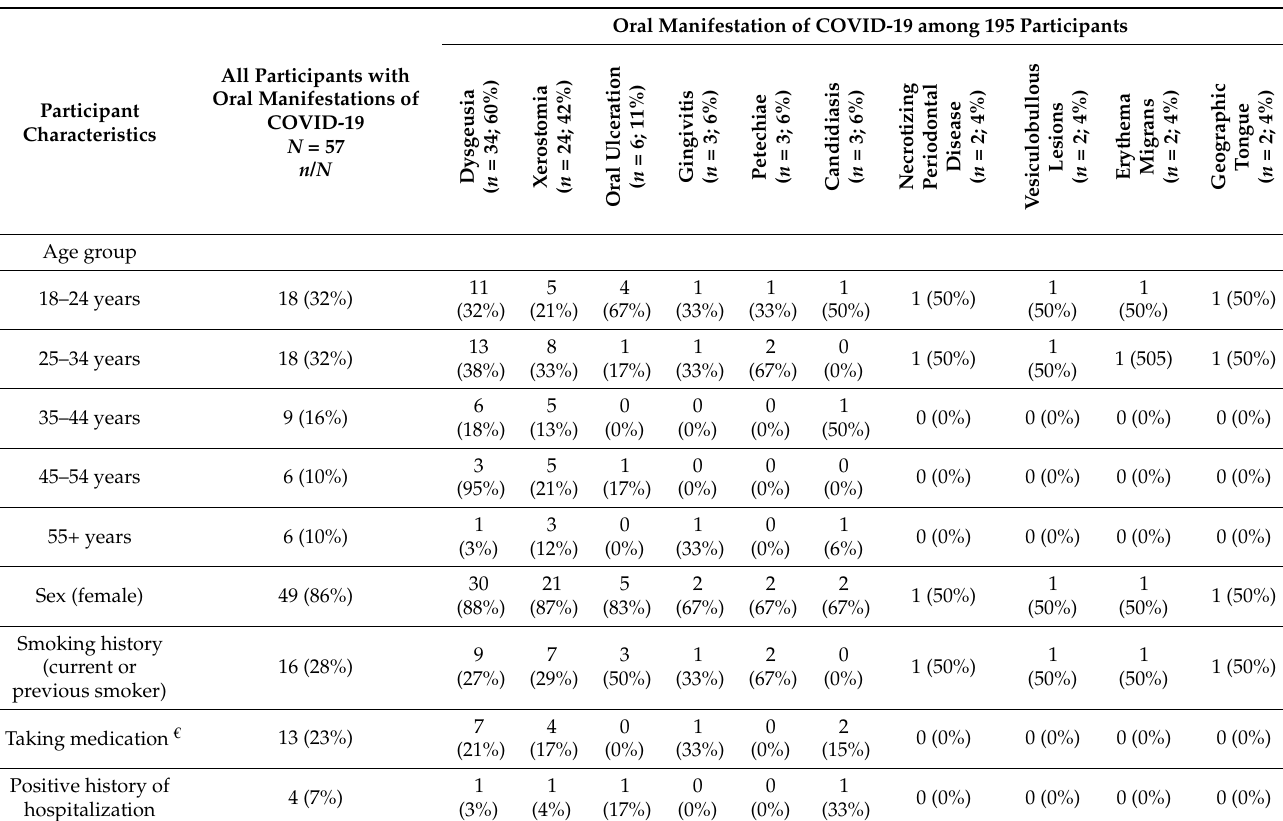
Table 3. Characteristics of patients with oral manifestations of